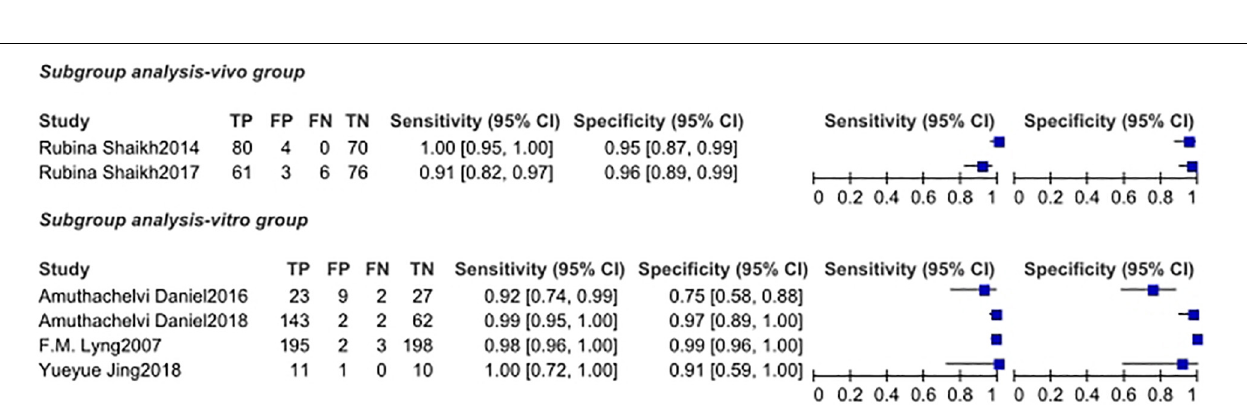
FIGURE 3 | The pooled date analysis of Raman spectroscopy (RS) in uterine cervical tumors. (A) The forest plot of pooled sensitivity and specificity of Raman spectroscopy to diagnose uterine cervical tumors of all the six studies. (B) The pooled PLR and NLR of Raman spectroscopy in diagnosis of uterine cervical tumors. PLR, positive likelihood ratios; NLR, negative likelihood ratios. (C) The SROC curve of Raman spectroscopy in diagnosis of uterine cervical tumors. SROC, summary receiver operator characteristics.